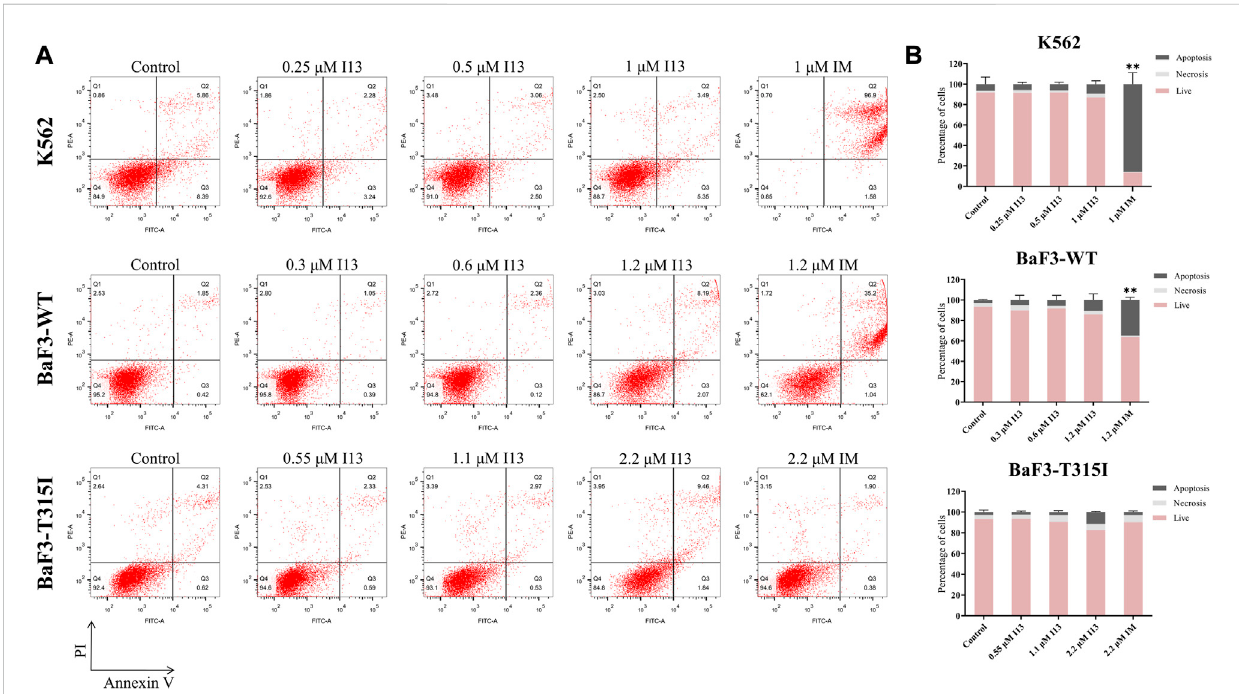
FIGURE 3 I13 had no signi fi cant effects on cell apoptosis in CML cells. (A) The effect of I13 on the cell apoptosis in cells incubated with I13 or imatinib for 72 h. (B) The bar graph showing the cell apoptosis rate. The K562 cell was incubated with 0.25, 0.5, and 1 µM of I13 or imatinib at 1 µM. The BaF3-WT cell was culturedwith0.3,0.6,and1.2 µMofI13or1.2 µMofimatinib. TheBaF3-T315Icellwasstimulatedwith0.55,1.1,and2.2 µMofI13or2.2 µMofimatinibfor 72 h (** p <